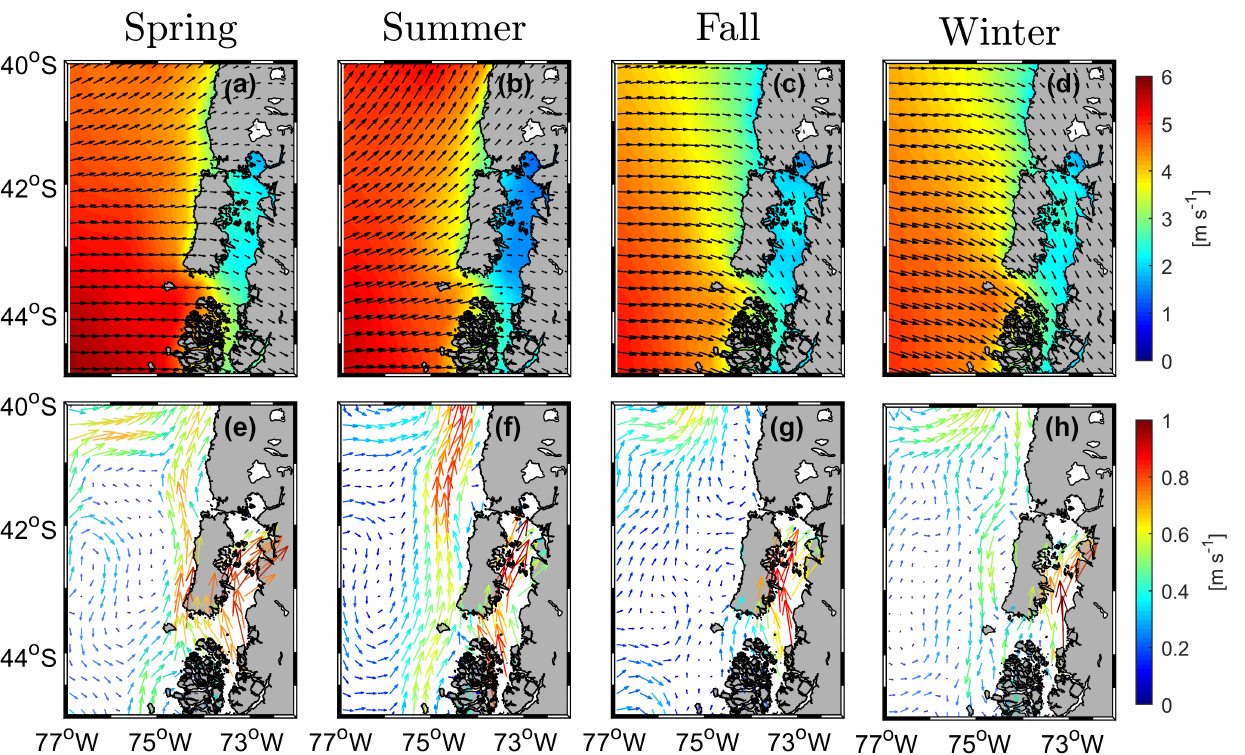
Figure 2. Seasonal climatologies of (upper panels) CCMP satellite wind vectors and (lower panels) AVISO satellite geostrophic velocities (2003–2019) for ( a , e ) spring (October, November, December), ( b , f ) summer (January, February, March), ( c , g ) fall (April, May, June), and ( d , h ) winter (July, August, September). The colors in ( a – d ) represent the wind speed. For reference of locations, see Figure